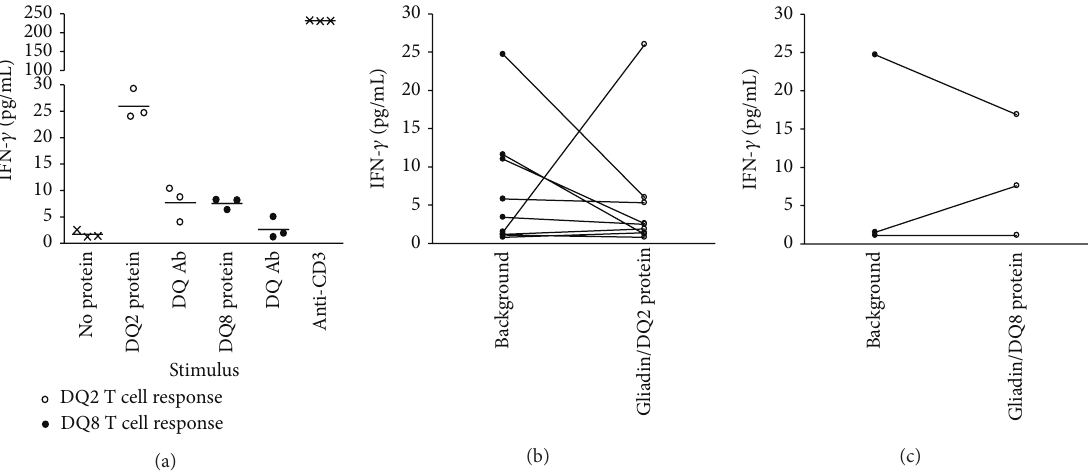
Figure 2: Recombinant peptide/MHC protein stimulates IFN- 𝛾 production from bulk unfractionated PBMCs. (a) Stimulation of PBMCs from a single subject in triplicate having both HLA-DQ8 and DQ2 alleles showing response to the recombinant proteins greater than background. The IFN- 𝛾 response is DQ restricted as it can be blocked with a monoclonal DQ antibody. An anti-CD3 monoclonal antibody is usedtostimulateTcellsasapositivecontrol.The 𝛼 -gliadinp1E,p9Epeptide(QQYPSG E GSFQPSQ E NPQ)ispresentintheDQ8recombinant protein, while 𝛼 -I gliadin (QLQPFPQP E LPY) is present in the DQ2 protein. (b) Summative stimulation data from nine subjects all with HLA- DQ2 (DQA ∗ 05:01, DQB ∗ 02:01). (c) Data from three subjects having the HLA-DQ8 (DQA ∗ 03:01, DQB ∗ 03:02) allele.